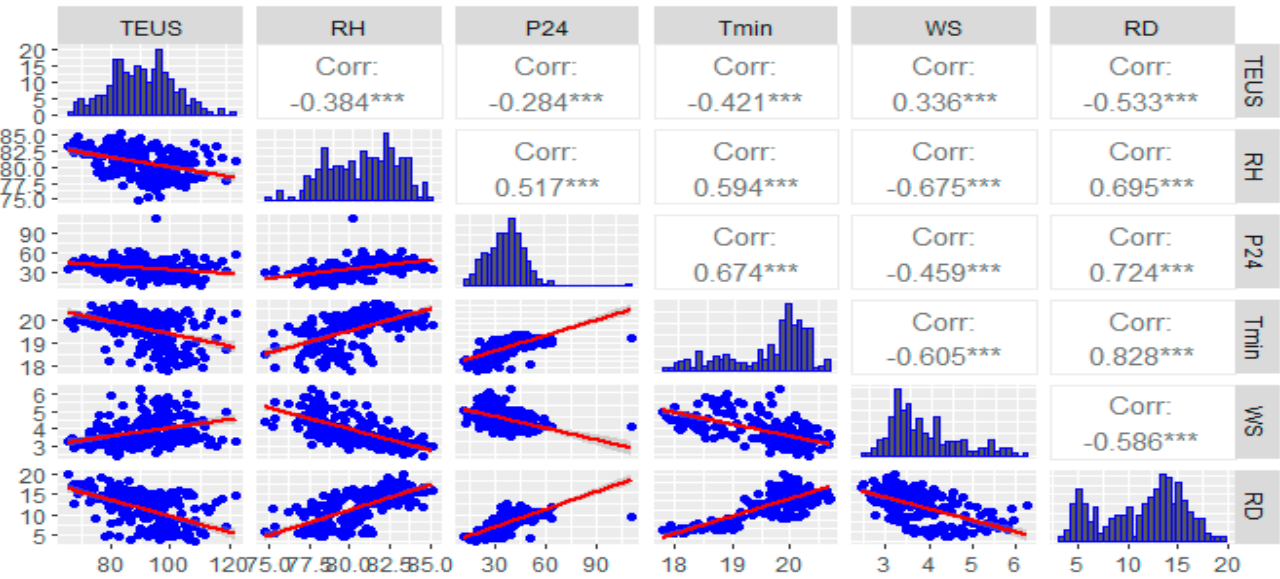
Figure 2. Scatterplot matrix showing the correlation study variables. The values of each variable were normalized by the transformation to its empirical percentile. See the legend of the study variables in the Appendix A. *** Statistically significant p -value of <0.0001.